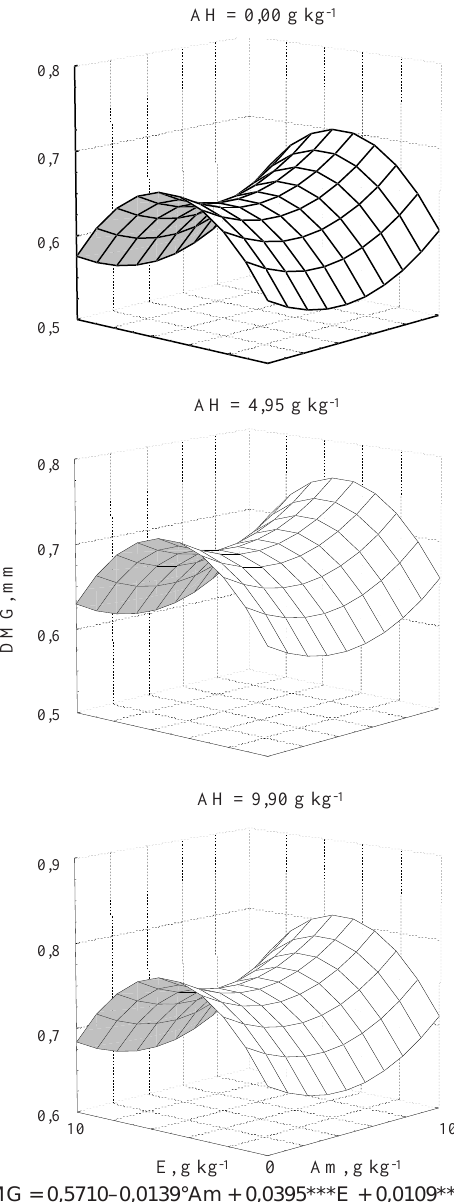
Figura 5. Diâmetro médio ponderado (DMP) dos agregados do horizonte A analisado por via úmida, considerando a adição de amido (Am) e ácido esteárico (E), para diferentes doses de ácido húmico (AH).